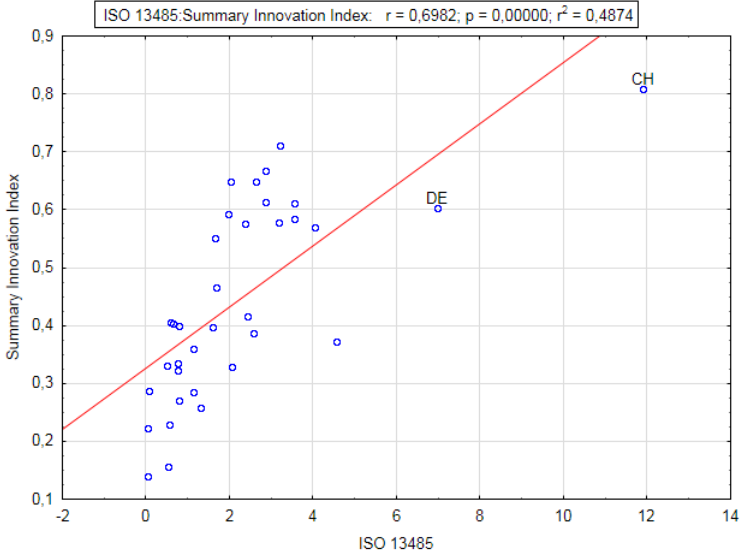
Figure 1. Scatter plot between ISO 13485 and